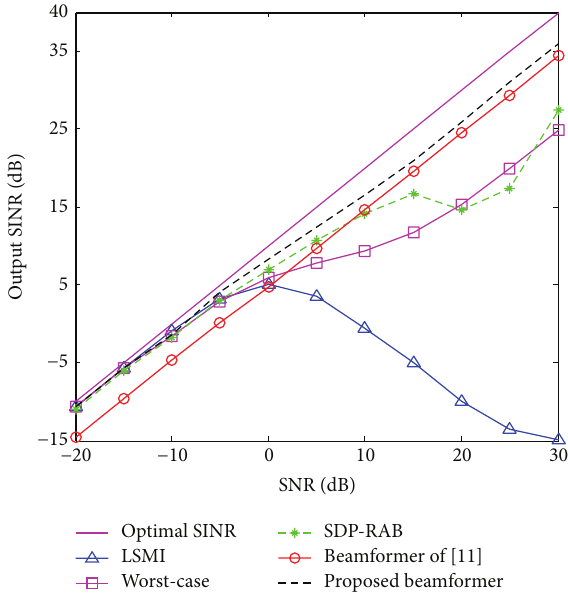
Figure7:OutputSINRofbeamformersversusinputSNRinthecase of coherent local scattering.